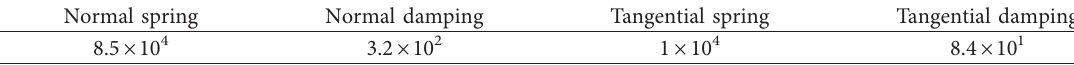
Table 3: Spring-damper unit parameters for the track slab and the subgrade.